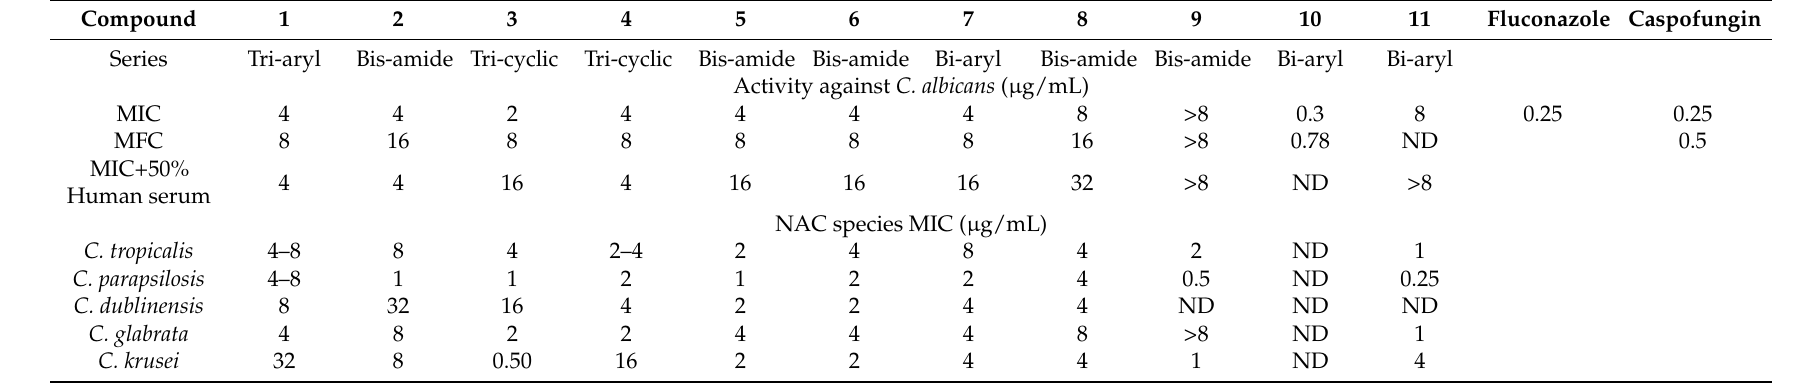
Table 1. MIC study of eleven HDP mimetics.